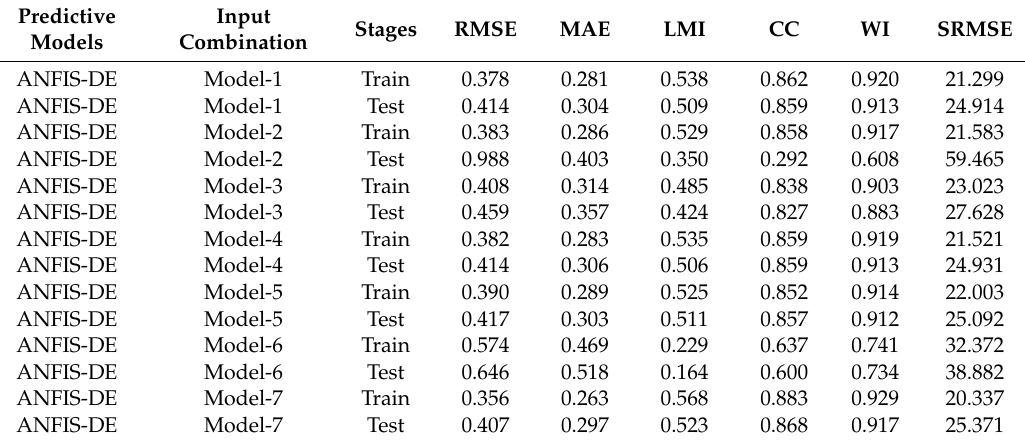
Table 4. The prediction performance of the hybrid ANFIS-DE model for all proposed input combinations over the training and testing stage. The boldface denotes the best modeling results.